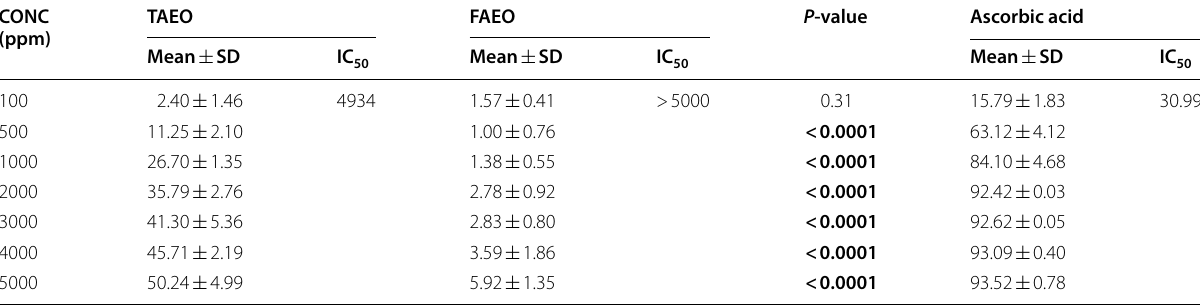
Table 3 Total radical scavenging activity (%) of Trachyspermum ammi essential oil (TAEO) and Ferula assafoetida essential oil (FAEO) and ascorbic acid